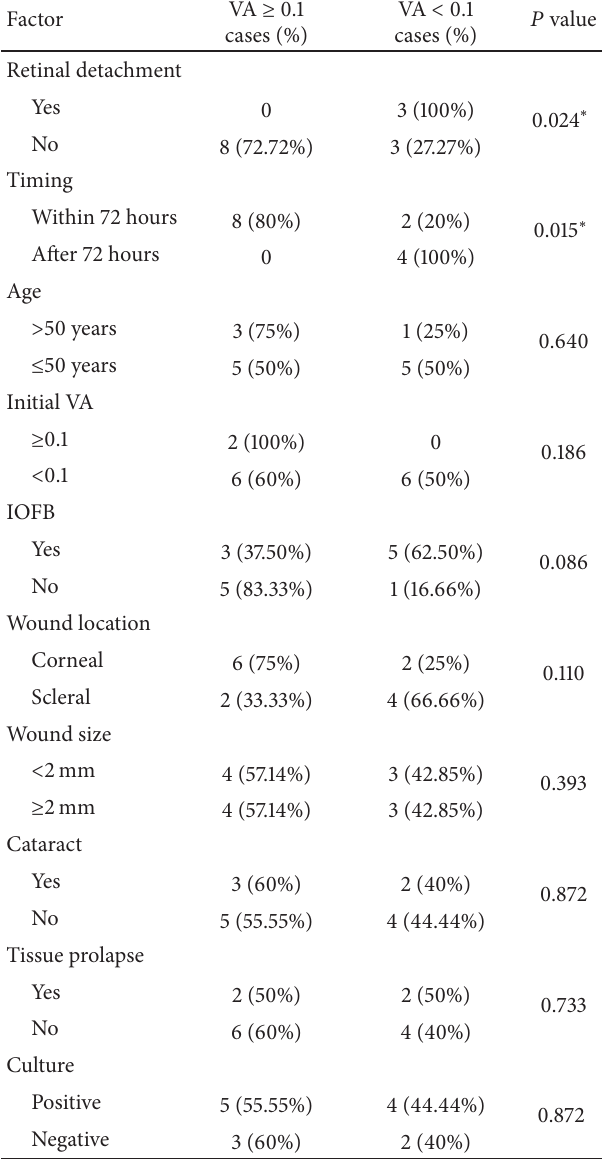
Table 4: Prognostic factors on our traumatic endophthalmitis